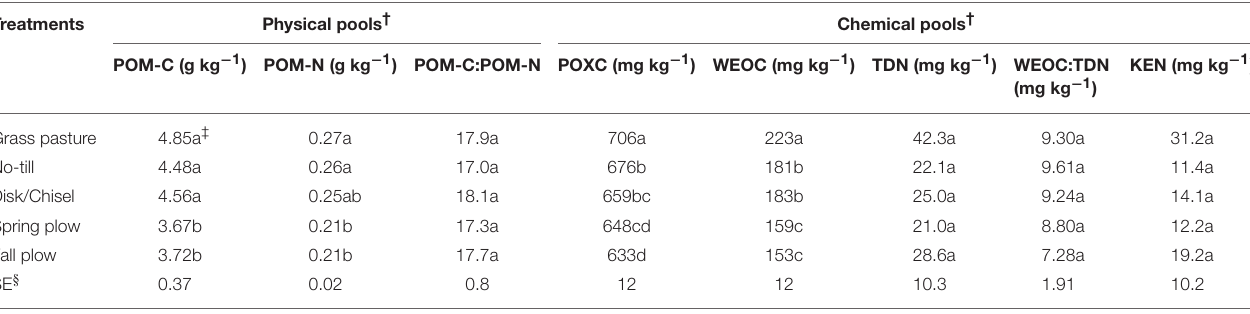
TABLE 2 | Treatment effects on physical and chemical pools of SOM in surface 0- to 15-cm Walla Walla silt loam near Pendleton, Oregon. Treatments Physical pools